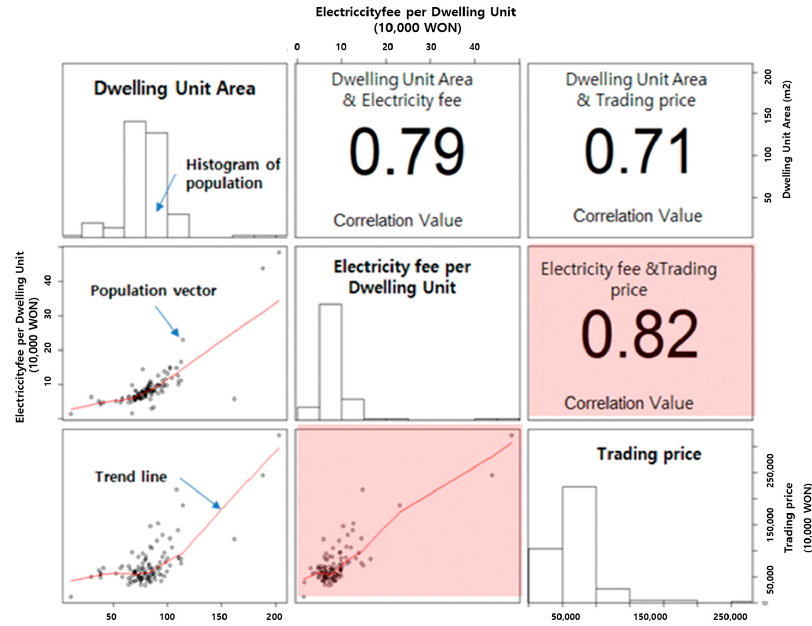
Figure 2. 2010~2015 range scale of Correlation analysis between market price and Annual electric energy fee.